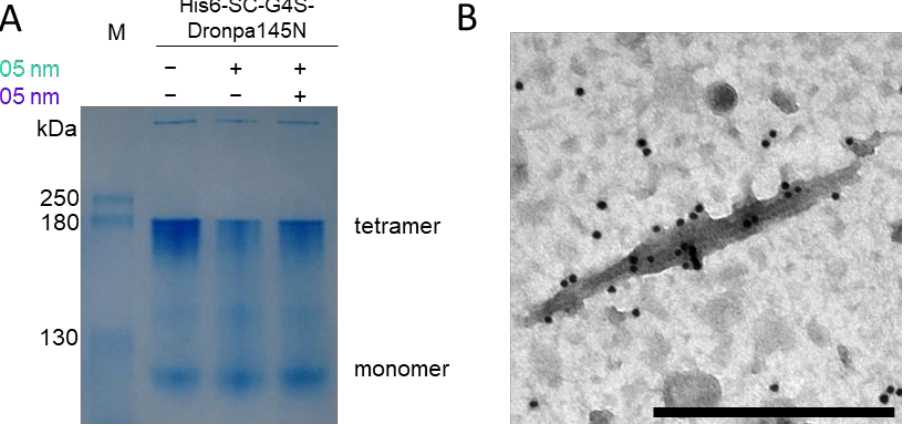
Figure 5. Analysis of the Dronpa145N system. ( A ) Analysis of the light-dependent association/dissociation behavior of Dronpa145N by discontinuous native PAGE. The monomeric state is favored under cyan light (505 nm) leading to the loss of signal intensity for the tetrameric form, but the latter is restored by exposure to weak violet light (405 nm) resulting in an increase in signal intensity. M = P7719 Color Prestained Protein Standards. ( B ) Transmission electron micrograph showing Dronpa145N attached to PVX particles. Purified PVX-ST/His 6 -SC-G4S-Dronpa145N particles were irradiated with cyan light (505 nm) before mixing with His 6 -mCh-G4S-Dronpa145N. The mixture was irradiated with violet light (405 nm) and particles were attached to grids. His 6 -mCh-G4S-Dronpa145N was detected with an anti-mCherry/GAM-12 nm gold conjugate. Immunogold decoration was observed for the mixture irradiated successively with cyan and violet light. Scale bar = 500 nm. Controls are shown in Figure S3.